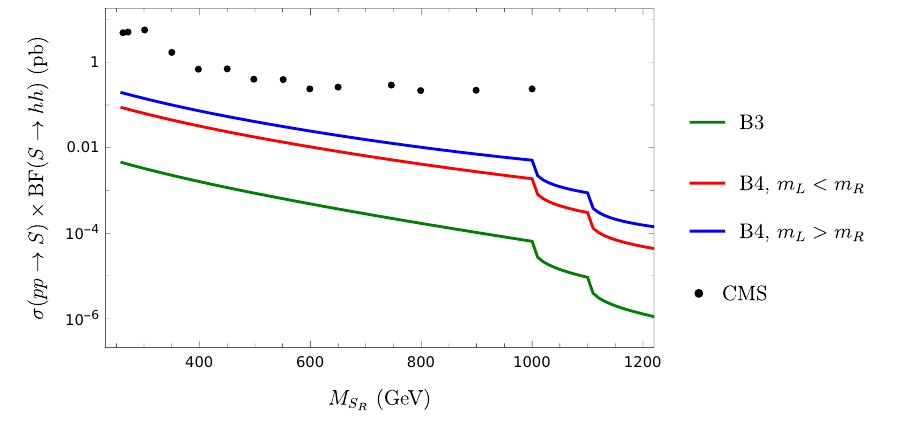
Figure 12 . Resonant Higgs pair production in benchmarks B3 and B4 (shown with both stop mass orderings). Black points represent the CMS observed exclusion bound from